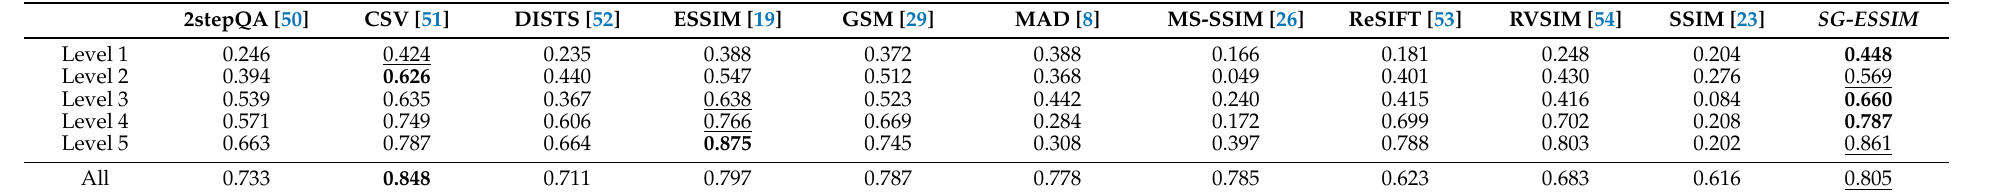
Table 8. Comparison of SROCC of each FR-IQA metrics on TID2013’s [7] distortion levels (Level 1 represents the lowest level of degradation, while Level 5 represents